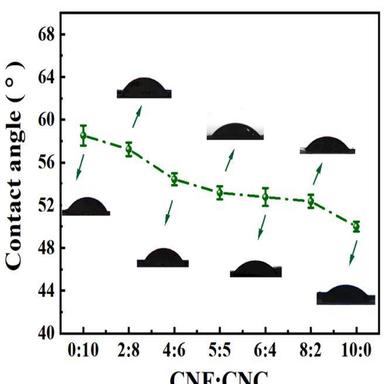
Water contact angle of nanocomposite films with different ratios of CNF/CNC.